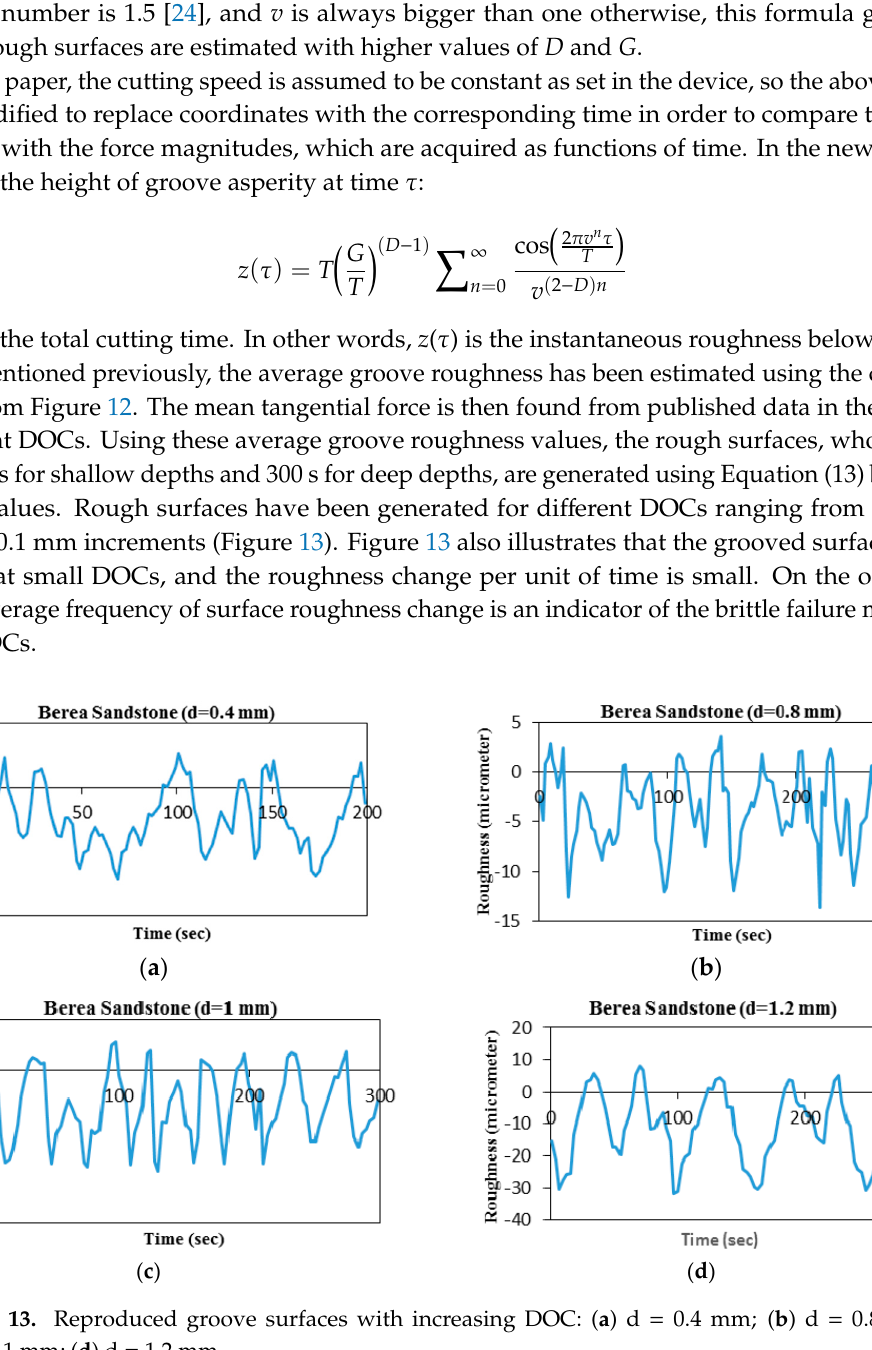
( d ) Figure 14. Variation of instant roughness change versus roughness change at DOCs: ( a ) d = 0.3 mm; ( b ) d = 0.9 mm; ( c ) d = 1 mm; ( d ) d = 1.4 mm. In addition, sometimes DOC variations do not affect the slope of the 𝑅 (cid:3047) versus Δ R graph, or it shows a significant rise at only few points. This behavior depends on cutting type during the cutting process. At shallow depths, powder is the dominant cutting type, and the number of chunk-like cuttings is small, so the slope of this graph remains almost constant even though 𝑅 (cid:3047) and ∆𝑅 values change constantly. However, this trend diminishes with an increase in the number of chunk-like cuttings. Beyond the transition point, the number of chunk-like cuttings increases, and the slope experiences a sharp increase. In parallel, the groove surface roughness shows significant changes in